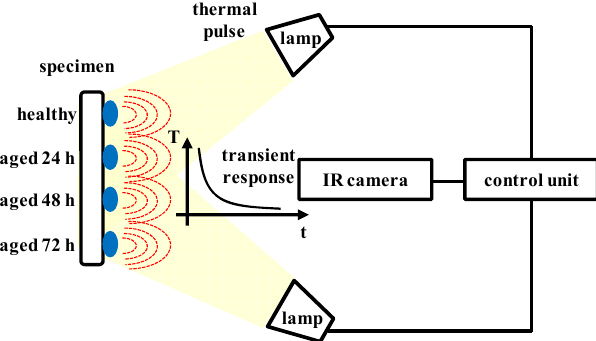
Figure 3. Schematic diagram of pulse thermography system used to obtain images of the thermal responses of lettuce